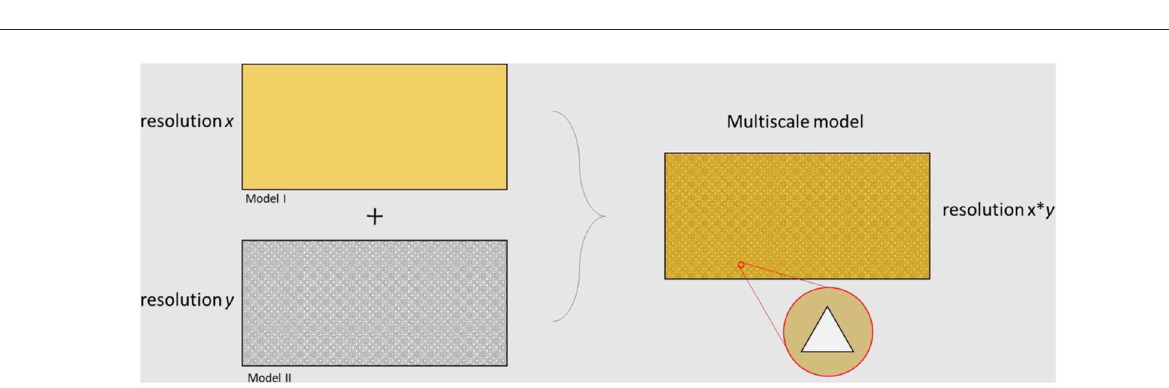
investigate interactions, either extracellular or intracellular, with different details. GutLogo, based on the NetLogo (134) agent-based modeling framework, is a new tool to